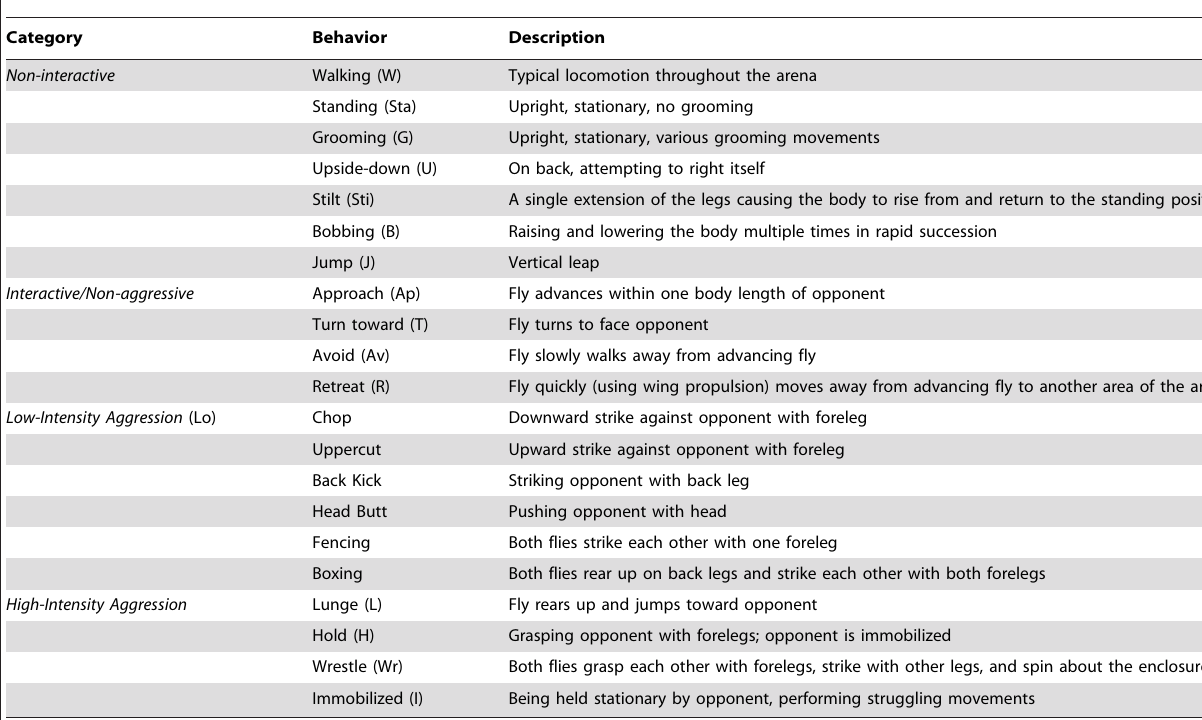
Table 1. Ethogram for male flesh fly behavior performed within the observation arenas.